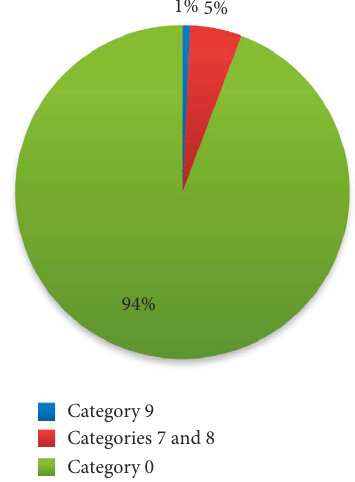
Figure 7: Landfill siting process results.